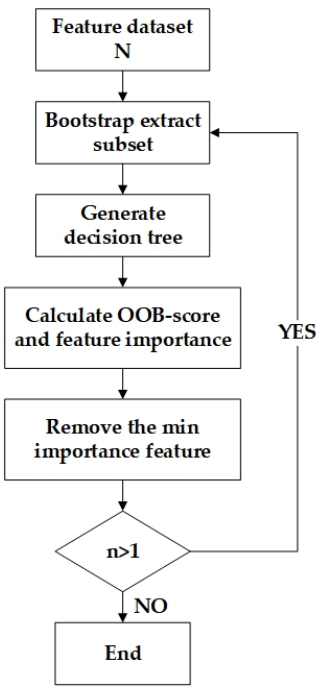
Figure 9. Flow chart of Out of Bag data with Recursive Feature Elimination (OOB RFE).